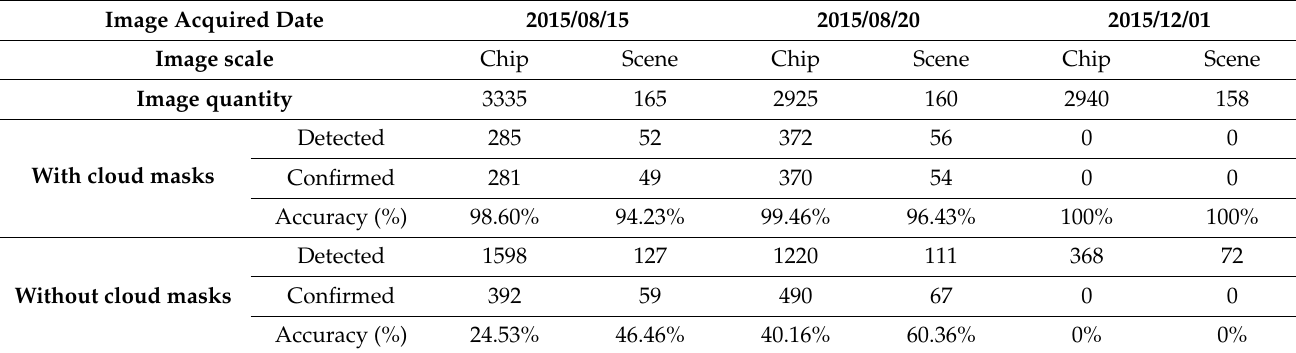
Figure 6. Influence of detection results with the introduction of cloud masks. ( a1 – b4 ) Compares the accuracy of the s2cloudless product and Band QA60 in two scenes with BBMR. The s2cloudless product identifies the range of the cloud more precisely than Band QA60 in most cases like ( a3 , a4 ), but sometimes also presents a false high value in areas like ( b3 ), leading to the mis-detection of BBMR. Table 1. Influence of introducing a cloud mask on detection